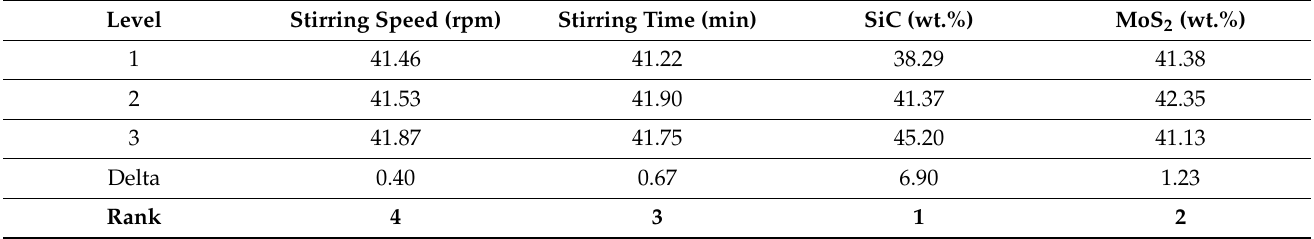
Table 8. Signal-to-noise ratio tensile strength of the composite (larger is